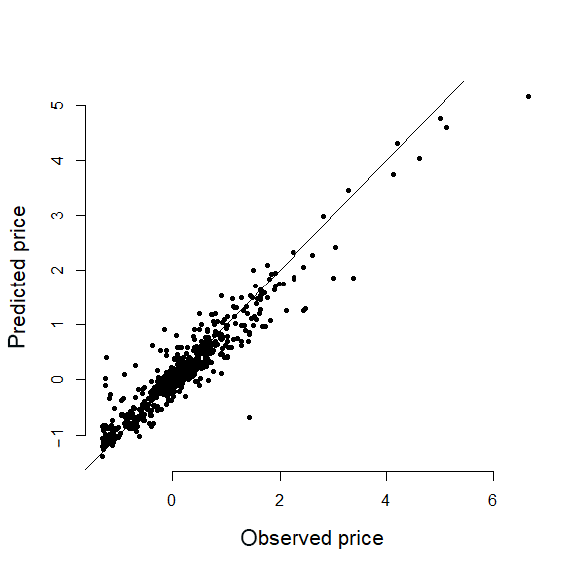
Figure 8. Reconstruction errors vs.